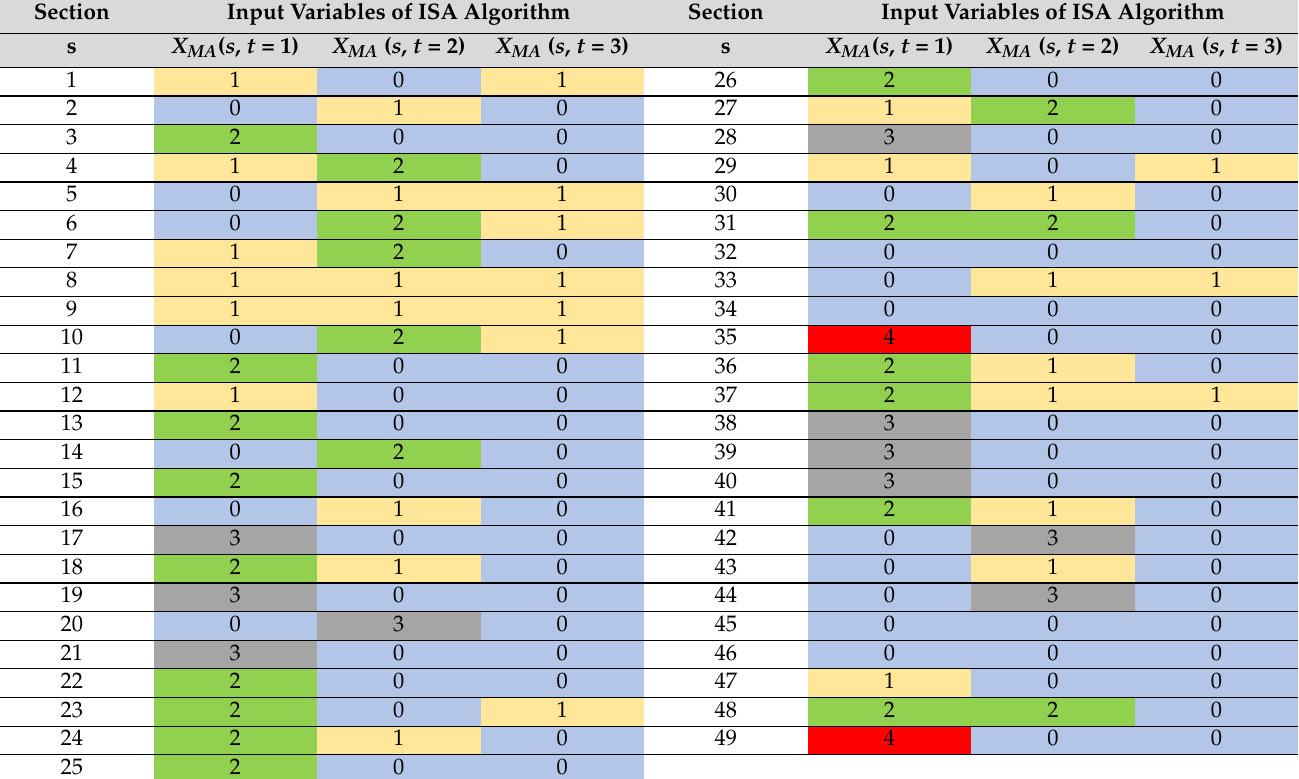
Table 4. Optimal maintenance activity plan by ISA algorithm to improve the pavement